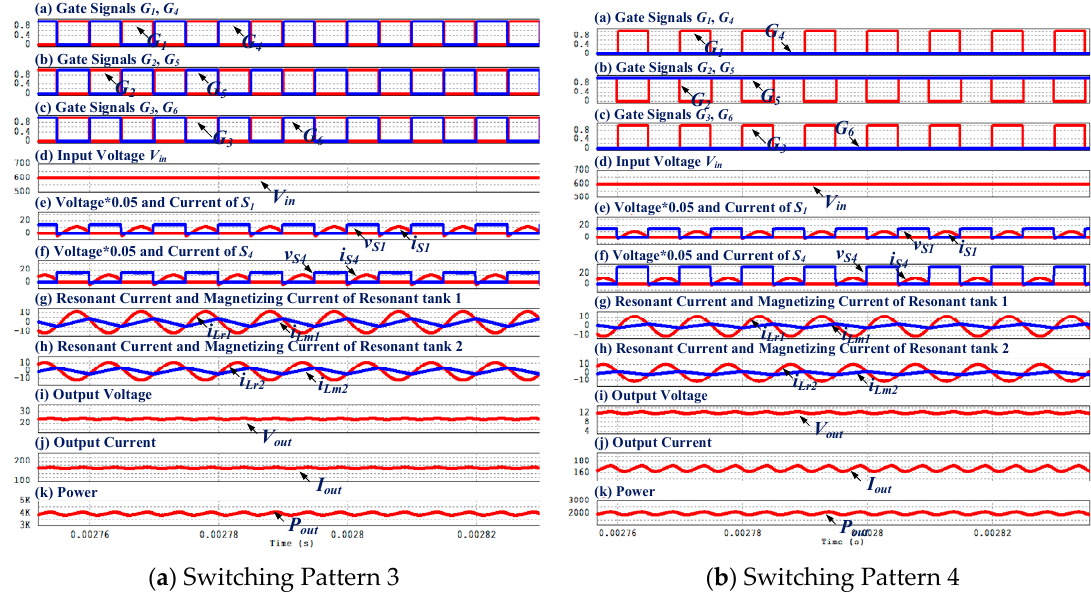
Figure 14. Simulation waveforms of Switching Patterns 3 and 4.